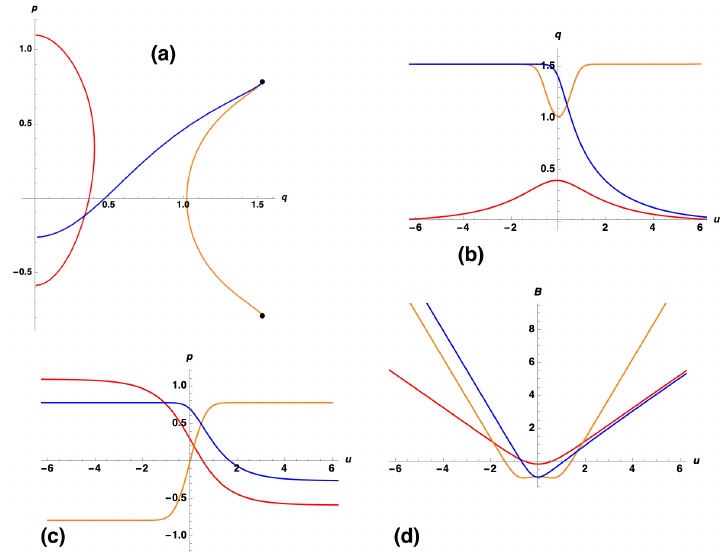
Figure 3 . (a) pq parametric plot, (b) plot of q , (c) plot of p , (d) plot of the metric function B as functions of the AdS slicing coordinate u for truncation 2